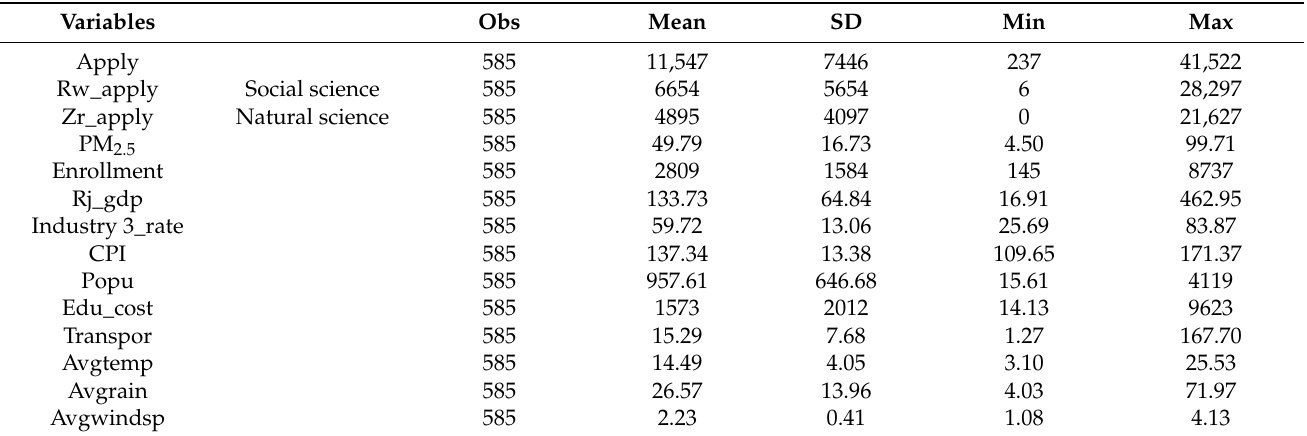
Table 1. Descriptive statistics of main